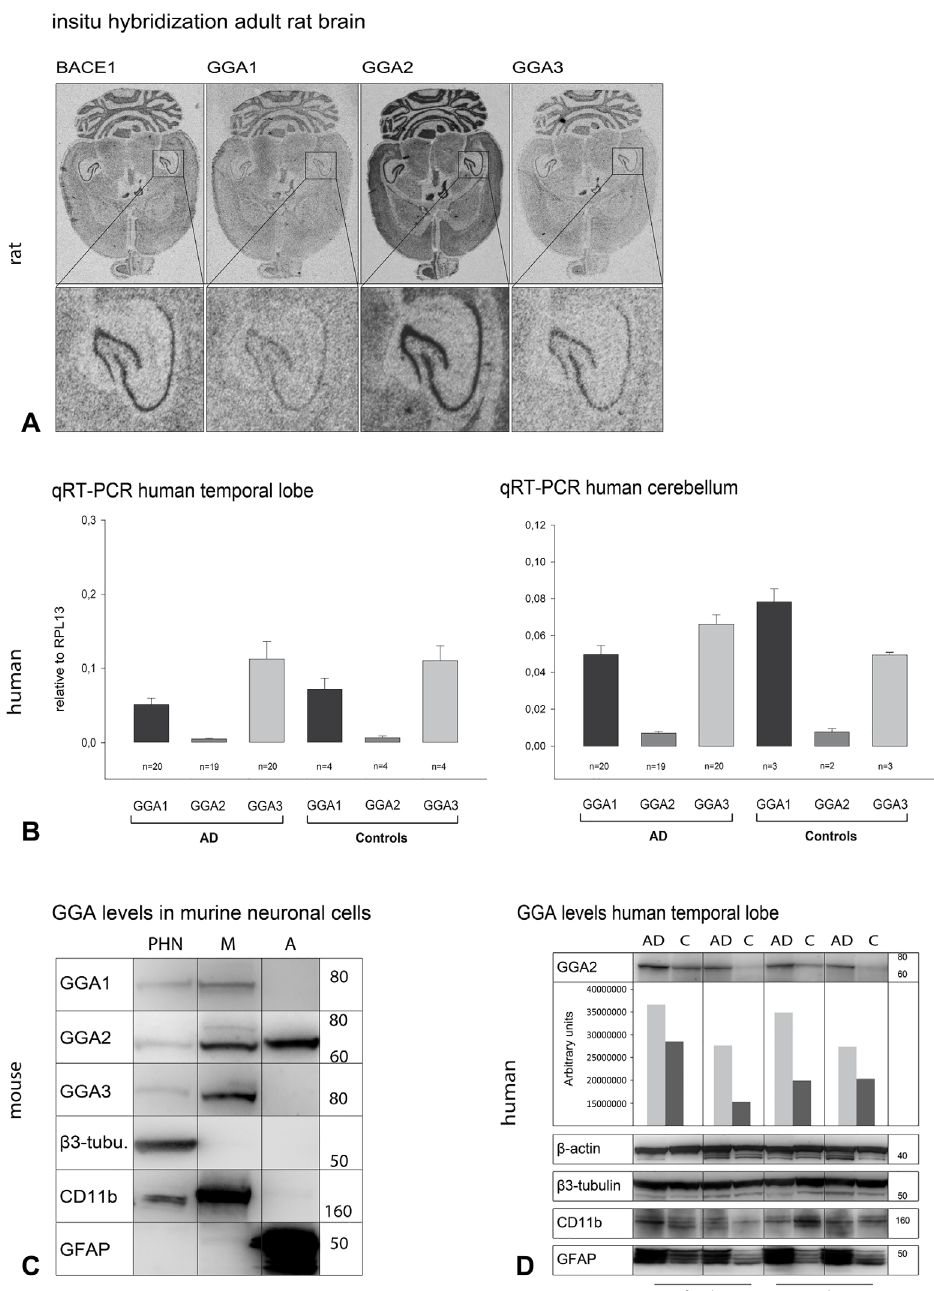
Fig 5. GGA1, 2, and 3 are differentially expressed and regulated in the brain. (A) In situ hybridization of subsequent horizontal sections of 5 month old male rat brain shows the neuronal expression of BACE1 as well as GGA1-3 in all brain areas investigated. The expression pattern of the genes is essentially identical with the highest mRNA levels in the granular cell layer of the cerebellum and within the hippocampal formation (see enlargement). A comparison of the mRNA levels of the different genes shows that GGA2 mRNA appears to have the highest mRNA concentration in brain. (B) mRNA levels of GGAs in human postmortem brain tissues were analyzed by qRT-PCR. We observed lower levels of GGA2 mRNA in temporal lobe and cerebellum samples as compared with GGA1 and 3 levels. No difference between controls and AD patients was observed either for GGA1, GGA3, or GGA2 levels. (C) Primary hippocampal neurons (PHN), microglia (M) and astrocytes (A) were obtained from E18.5 C57/Bl6 mice. GGA protein levels were analyzed by Western blot. Purity of the cell types were controlled by appropriate marker proteins. All three GGAs are expressed in PHN as well as microglia, but GGA2 was exclusively detectable in astrocytes.